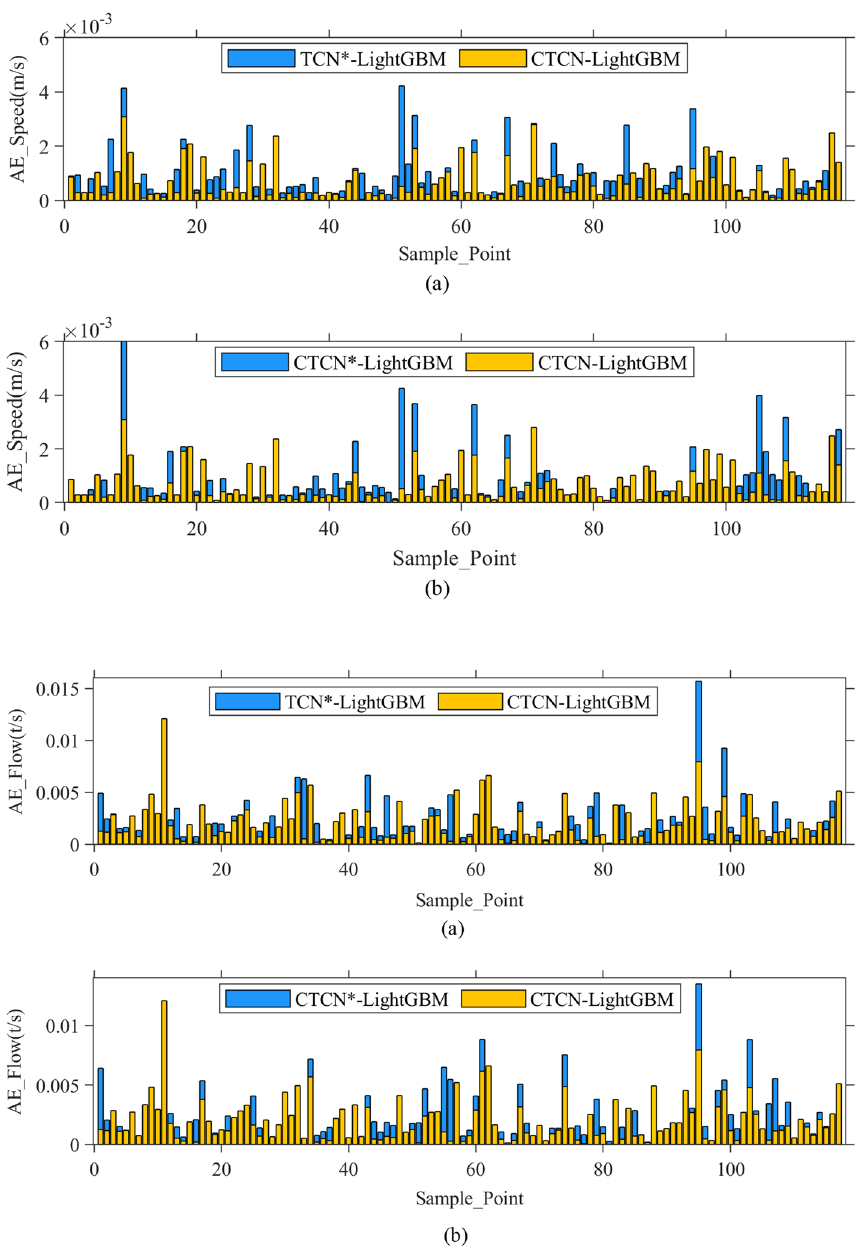
Fig. 8 Actual prediction results for truck speed adjustment